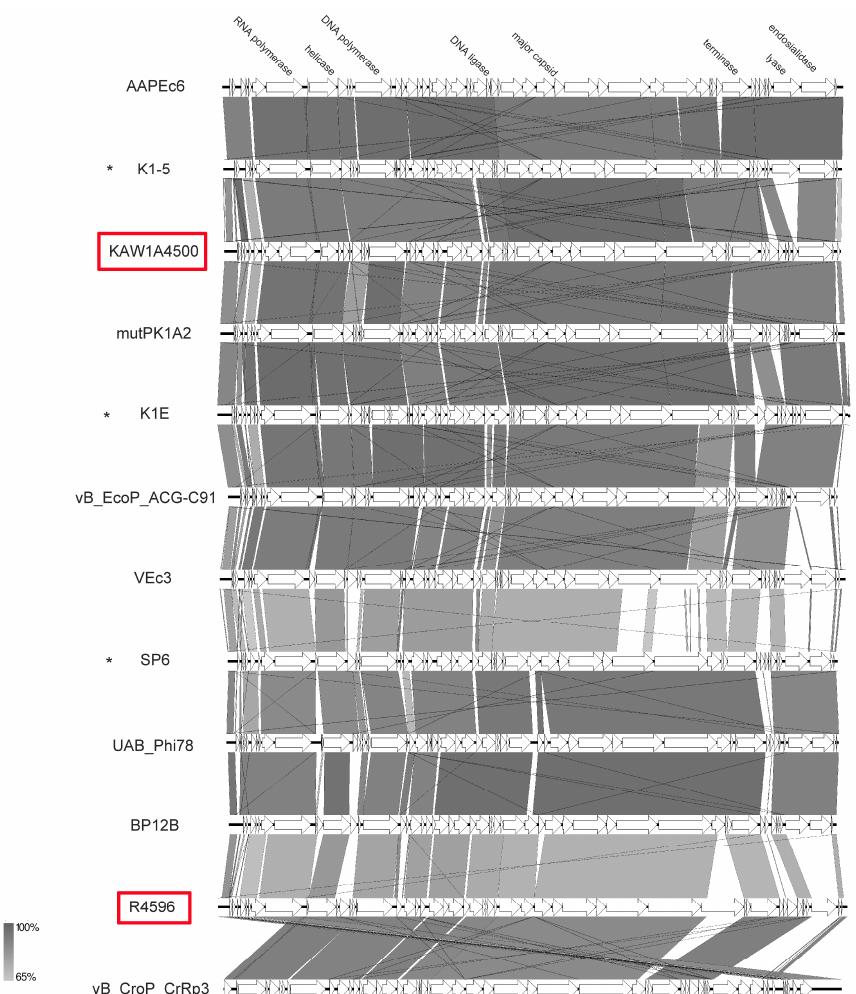
Figure 12. Genomic organization of phages R4596 and KAW1A4500 compared to selected zinderviruses at the nucleotide level. The figure was generated with EasyFig [48]. Asterisks indicate o ffi cial classification as Zindervirus already ratified by ICTV. Isolates of this study are marked in red.